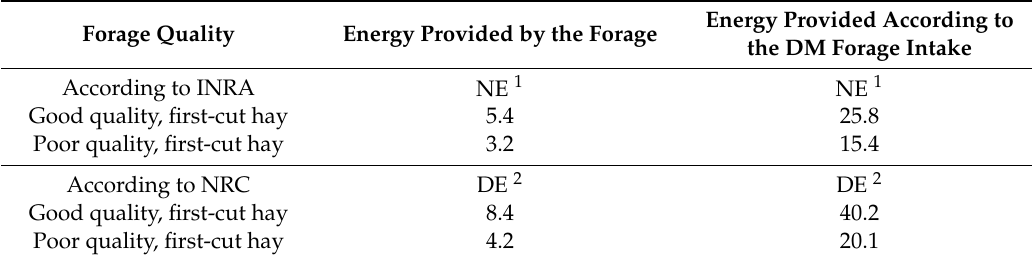
Table 3. Theoretical diets considering di ff erent forage qualities for a dairy donkey (300 kg BW) during the first three months of lactation *.